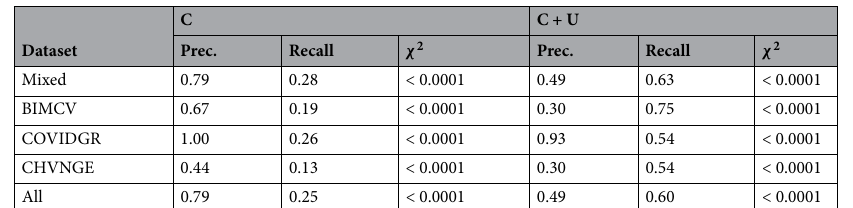
Table 3. Agreement between radiologists after consensus and ground truth considering as positives only CXRs marked as Indicative of COVID-19 (C) or Indicative of COVID-19 and Undetermined (C + U). χ obtained with the McNemar